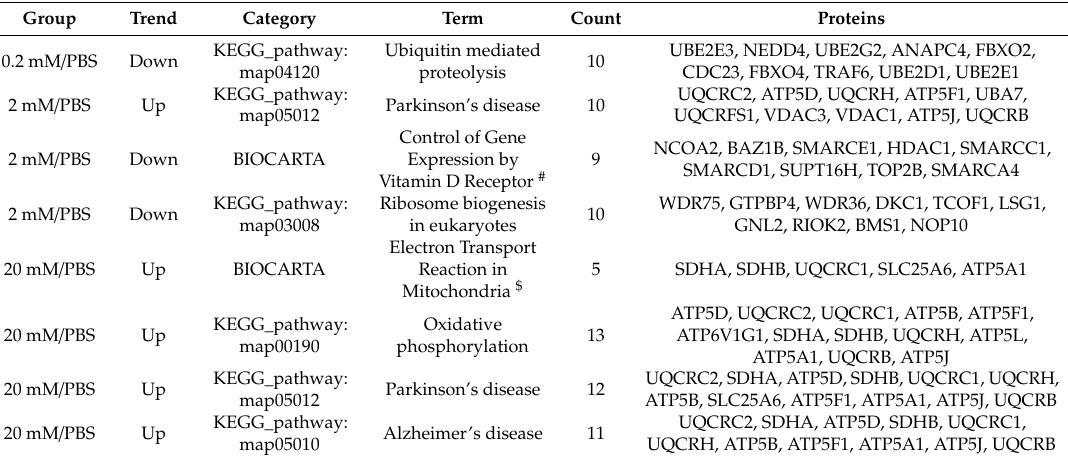
Table 2. Pathway enrichment.